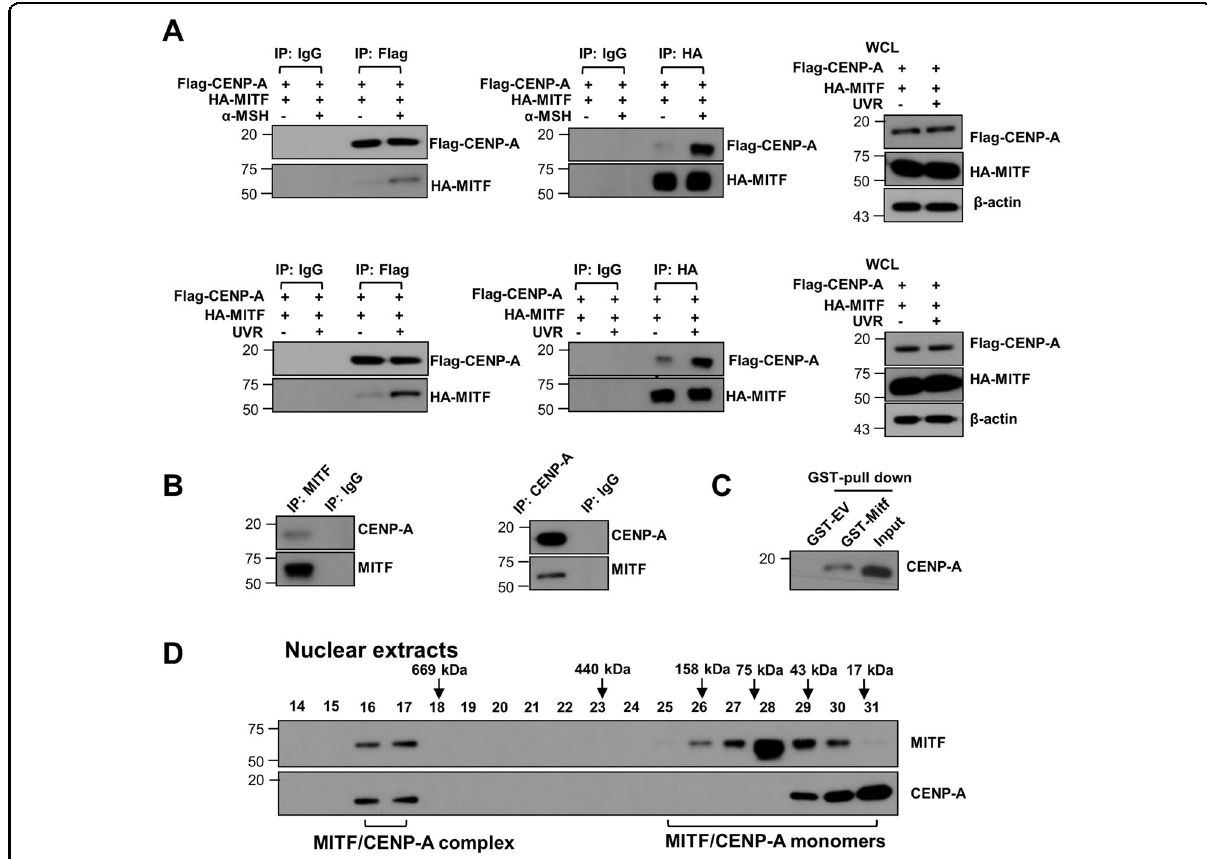
Fig. 5 Mitf directly interacts with CENP-A in melanocytes. A HA-Mitf and Flag-CENP-A were transduced into HPMs. Binding of Mitf to CEPN-A was con fi rmed with Co-IP. B Interaction between endogenous Mitf and CEPN-A in HPMS was detected with Co-IP using the indicated antibodies. C GST- Mitf pulled down CENP-A expressed in HEK cells. Blot was probed with antibody against CENP-A. D Whole-cell lysates from HPMs were subjected to the Superdex 200 size-exclusion column to separate proteins at different sizes. The lysates collected at various fractions were separated by SDS – PAGE before immunoblot (IB)